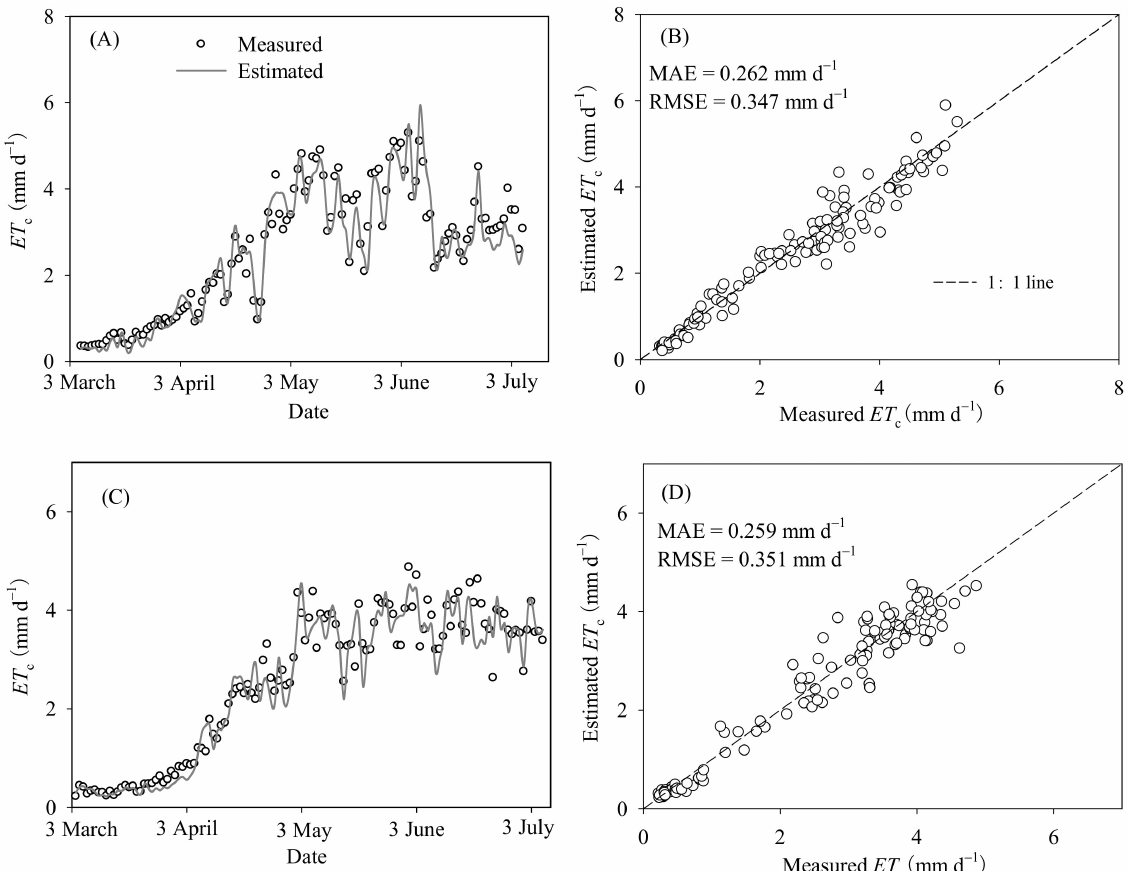
Figure 6. Comparison of measured and estimated crop evapotranspiration ( ET c ) of greenhouse- grown eggplant in the 2018 ( A , B ), and 2019 ( C , D )